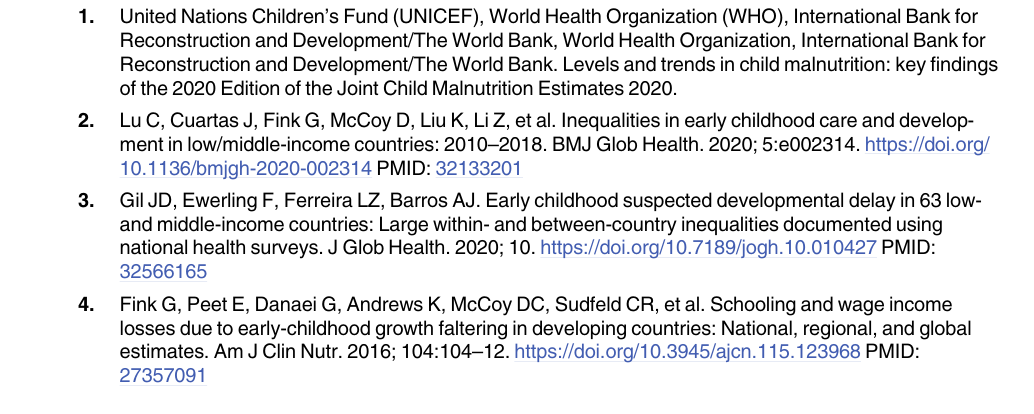
S3 Table. Results using the alternative definition of decision-making indicators. Table A. Associations between women’s total empowerment and empowerment dimensions (continu- ous and quintile categories) and child outcomes, using the alternative definition of decision- making indicators. Table B. Associations between women’s total empowerment and empow- erment dimensions (continuous and quintile categories) and care outcomes, using the alterna- tive definition of decision-making indicators. S4 Table. Effect heterogeneity of the association between women’s total empowerment and child and care outcomes by household wealth and maternal education, comparing women the highest quintile category to women in the lowest quintile